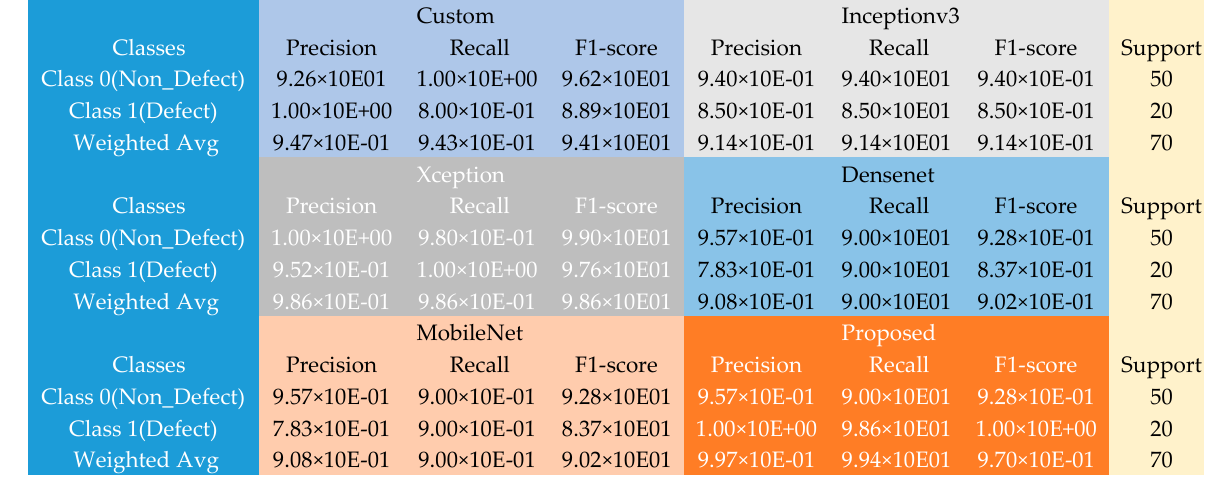
Figure 3. The confusion matrix table using the piston dataset.